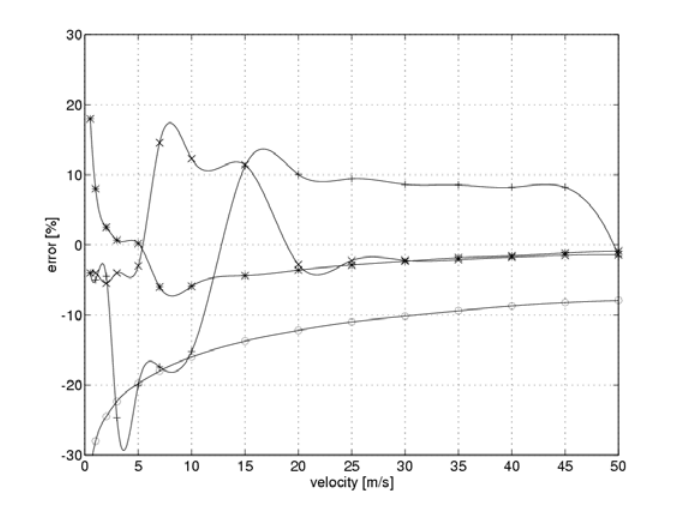
Figure 7. Relative error in velocity measurement during model testing ("*" - optimal, "o" - minimum, "+" – intermediate, "x" – maximum gain